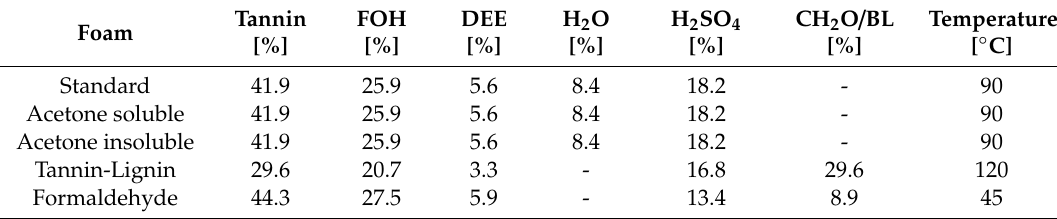
Table 1. Formulations used for foam